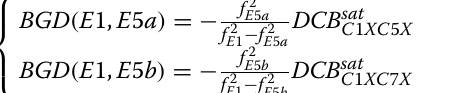
DCB estimates with an accuracy of 0.1 ns provided by the German Aerospace Center (DLR) were applied as refer- ence values. Figure 1 shows the statistics of the differ- ences between BGDs and DCBs for each Galileo satellite from 2015 to 2018. The BGD parameters for the entire constellation show agreement with the DCB estimates.